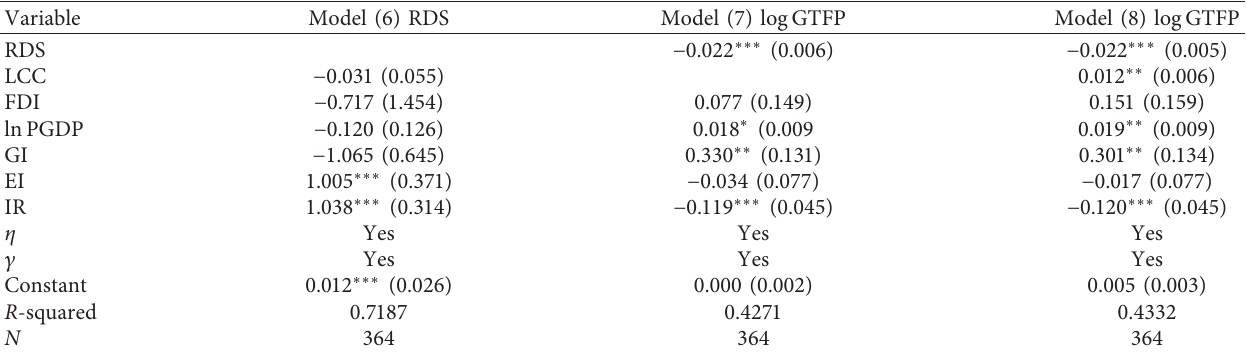
Table 7: The intermediary mechanism of the number of R&D staff.